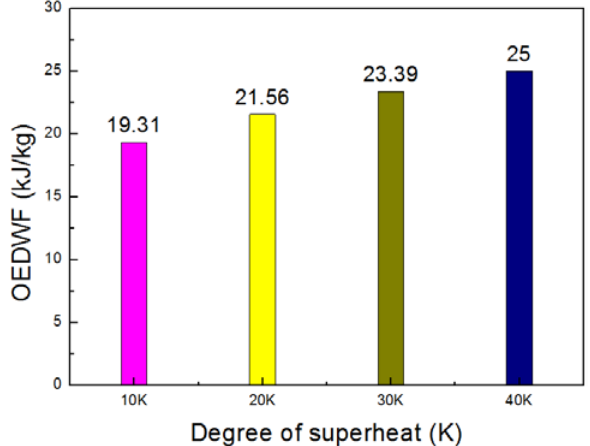
Figure 11. Comparison chart of output energy density of working fluid (OEDWF) for different degrees of